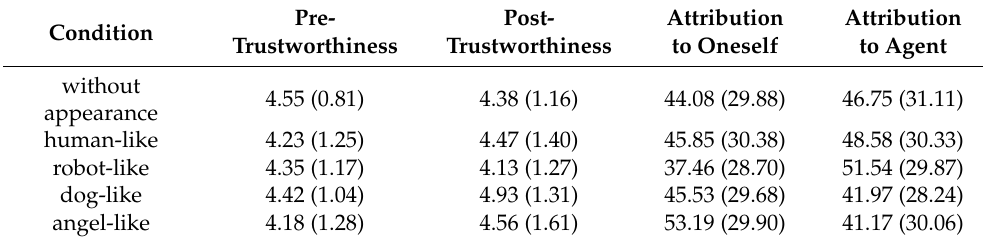
Table 5. Averages (SDs) for each dependent value for each condition.